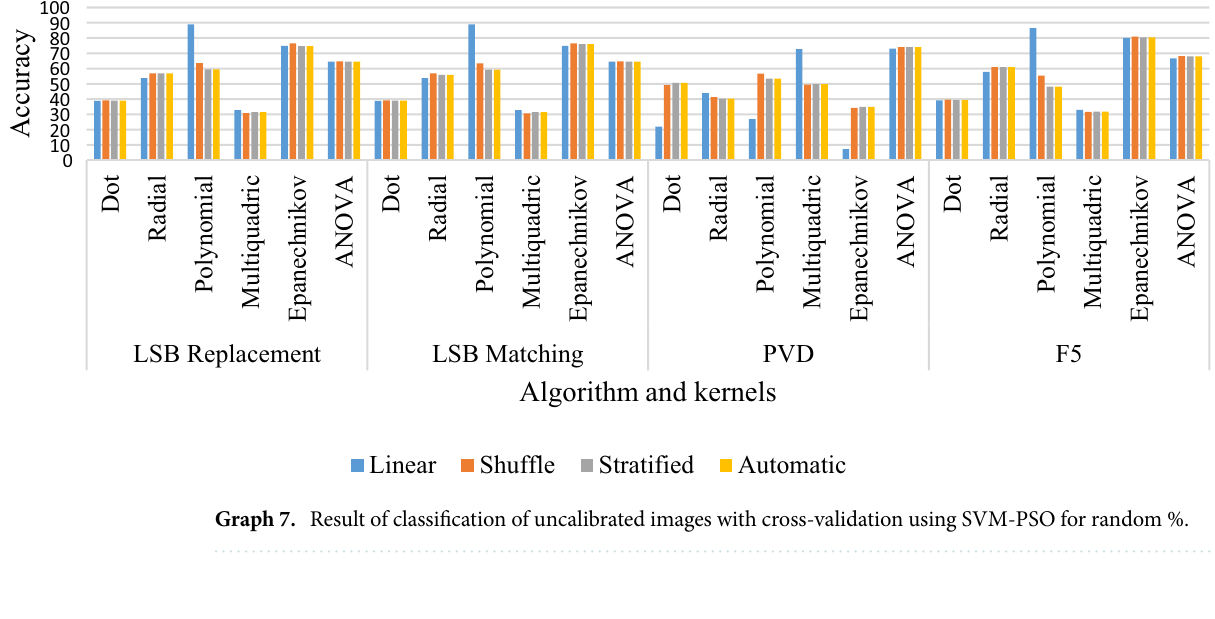
Linear Shuffle Stratified